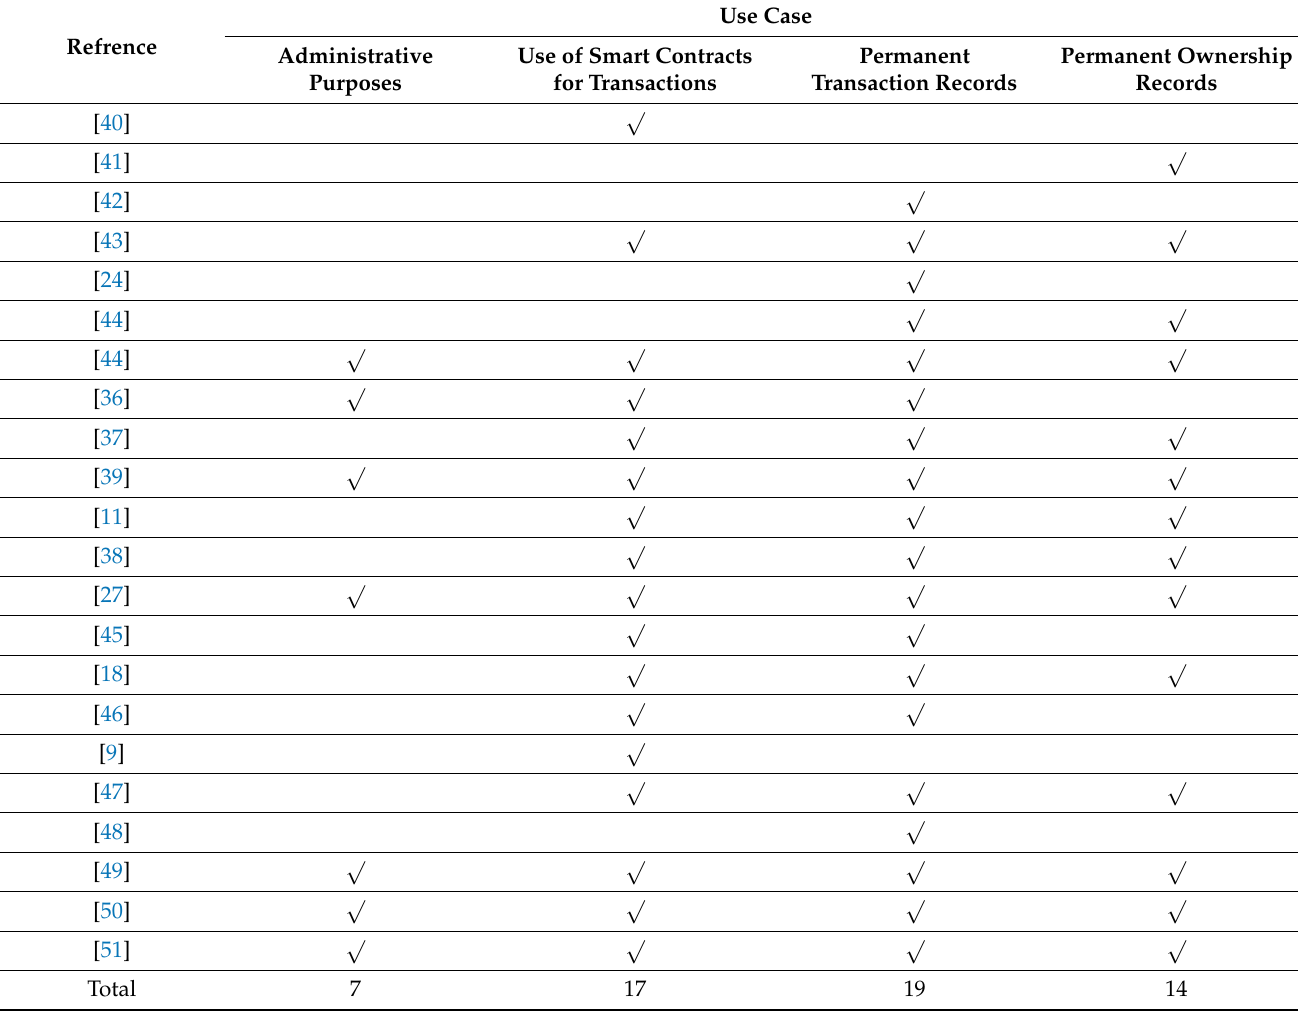
Table 1. Summary of the researched papers on blockchain technologies (BCTs) cases in the construction